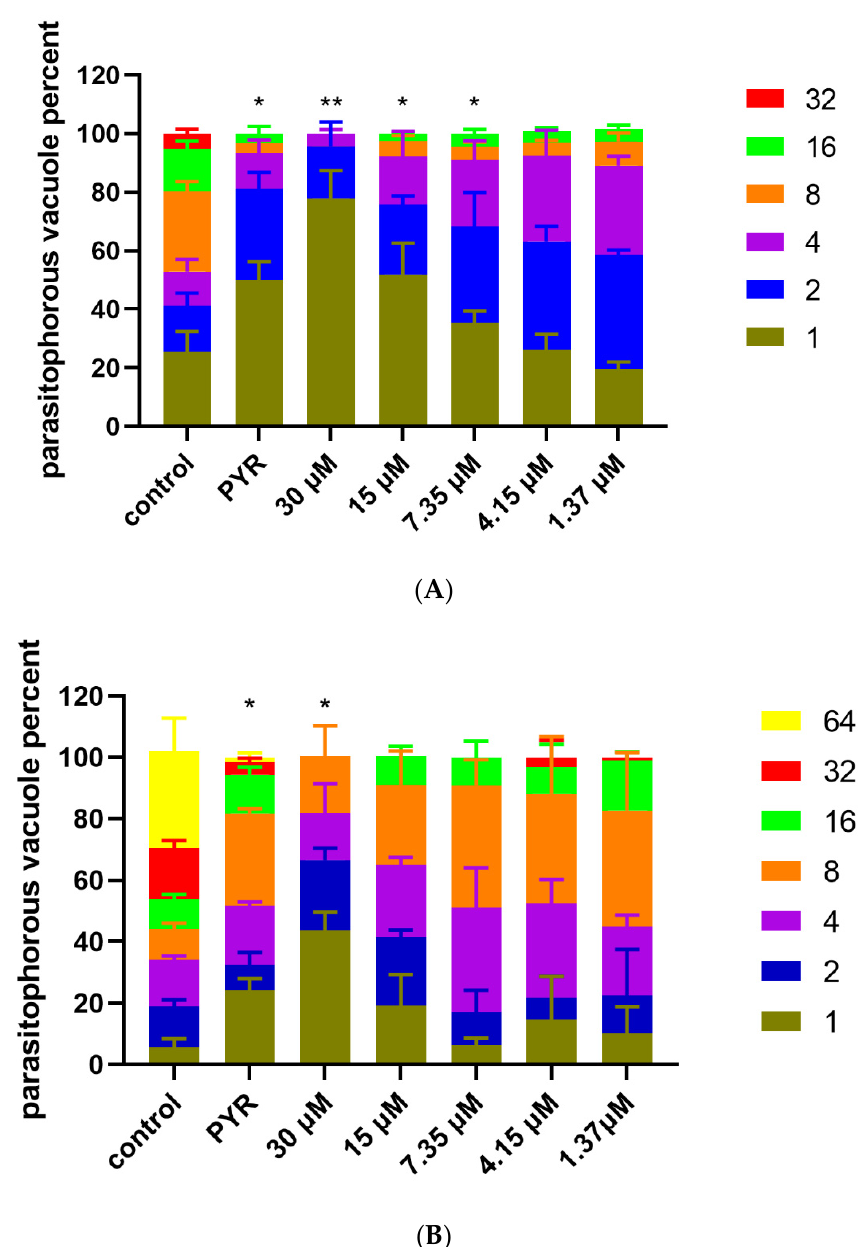
Figure 6. Effect of artemether on the T. gondii intracellular proliferation. The intracellular proliferation was examined after T. gondii tachyzoites were treated with different concentrations of artemether for 48 h ( A ) and 24 h ( B ). 1, 2, 4, 8, 16, 32 and 64 represent the number of tachyzoites in each PV. The experiments were performed in triplicate, and 3 technical replicates were included in each experiment. Significant differences compared to the control are indicated by * p < 0.05, ** p < 0.01.